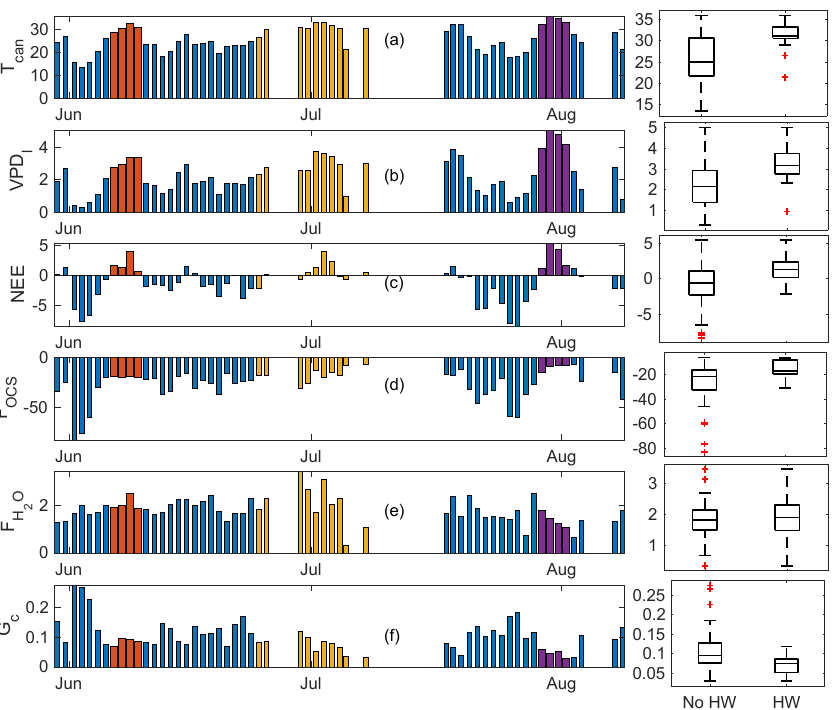
Figure 7. Daytime means (defined as periods when PAR > 100µmolm − 2 s − 1 ) for three heat wave periods (plotted as red, yellow, and purple, while the overall time series is shown in blue). Variables displayed are canopy temperature ( ◦ C; a ), VPD-leaf (b) , F OCS (c) , NEE (d) , water vapor flux (e) , and canopy conductance (Gc, f ). Units for each panel are the same as specified in previous